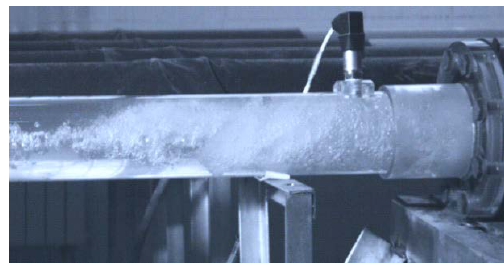
Figure 3. Completely atomized vaporization state.